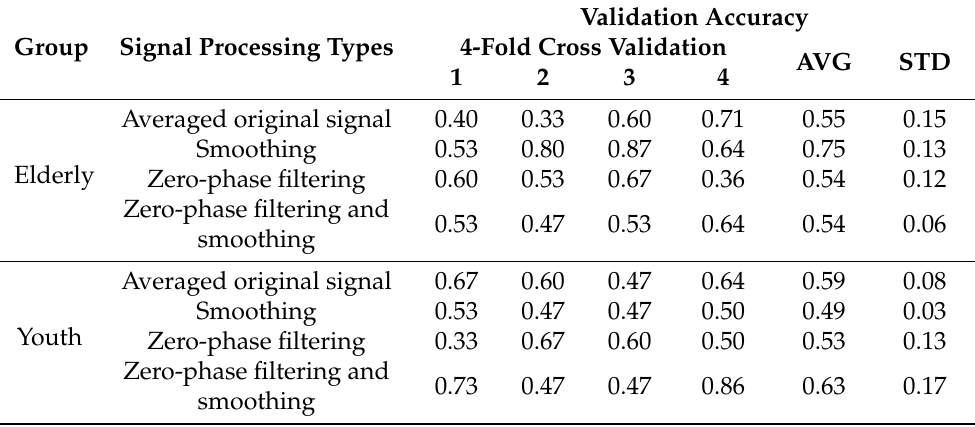
Table 5. 4-fold cross validation results: The smoothing signal processing for the elderly and the zero-phase filtering and smoothing case for youth showed the highest